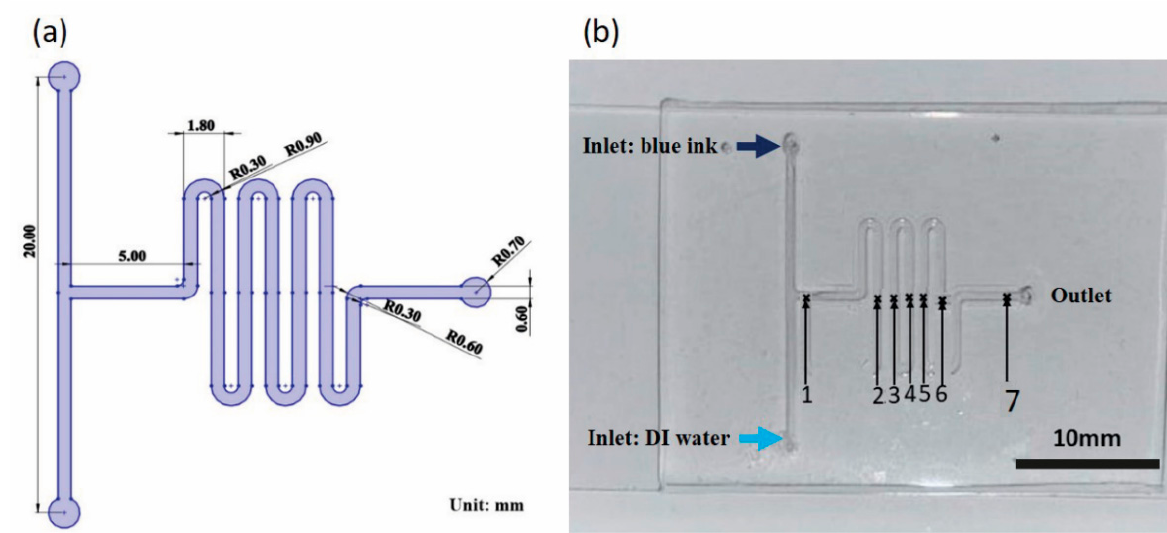
Figure 1. ( a ) Schematic illustration showing microfluidic device design and ( b ) photograph of actual microfluidic device.